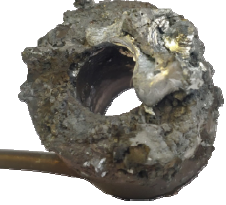
Figure 11. Failure mode by excessive corrosion of the heating set incapacitating the coil heater.